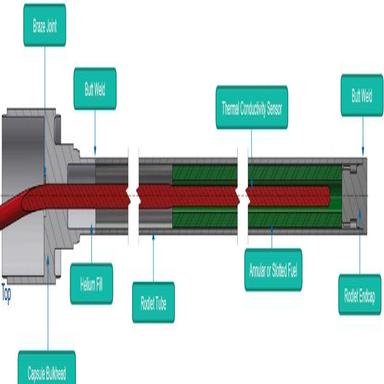
Shows a cross-section view of the IMPACT rodlet assembly.